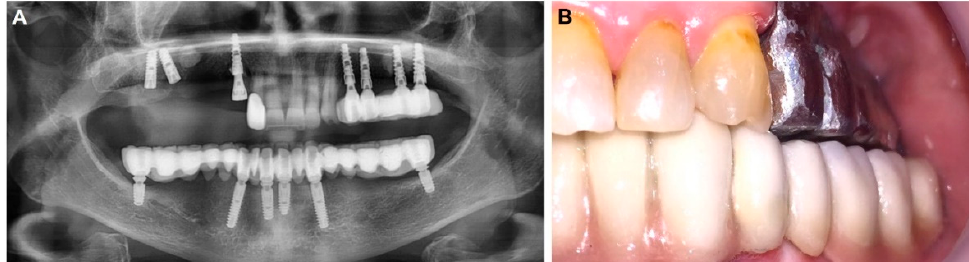
Figure 4. Provisional prosthesis was mounted in the same session after sinus lifting using Paste-CPC. The prosthetic stage started on the tenth week. ( A ) Orthopantomagram shows the metal prosthesis on the right side, and the cement is seen near the cranial end of the implants. ( B ) The metal framework try-in on the right side.